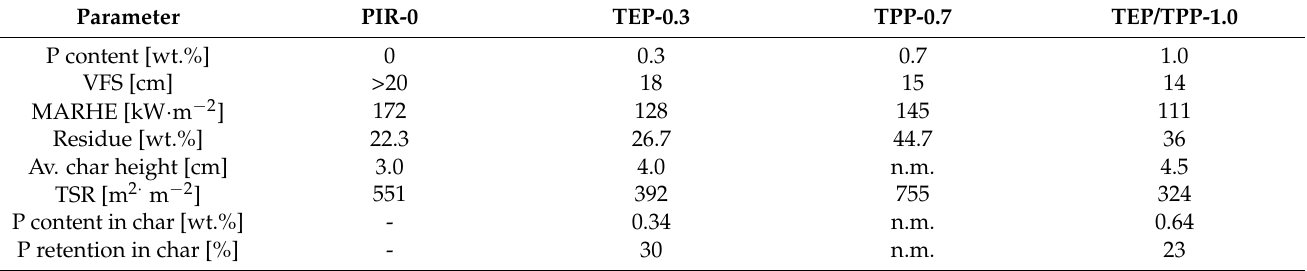
Figure 4. HRR vs. time curves of selected PIR foams obtained under forced flaming conditions in the cone calorimeter (50 kW · m − 2 ) (—: PIR-0; —: TPP/TEP-1.0 ; —: EA-BPPO/TEP-1.0 ; —: FU-BPPO/TEP-1.0 ; —: TA-BPPO/TEP-1.0 ; —-: TA-DOPO/TEP-1.0 ). Table 6. Comparison of fire-relevant parameters and structure of the chars remaining after cone calorimeter tests of closed-cell PIR control and reference foams.